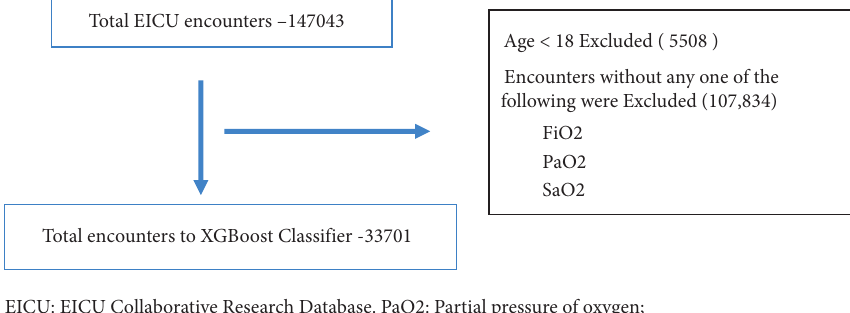
Figure 1: Inclusion flowchart. EICU: EICU Collaborative Research Database. PaO2: partial pressure of oxygen; FiO2: fraction of inspired oxygen; SaO2: oxygen saturation.